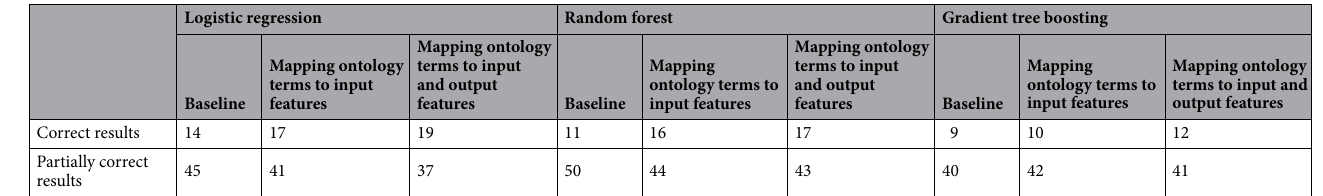
Table 3. Comparative evaluation of ontology-based feature engineering in the logistic regression, random forest, and gradient boosting tree models.